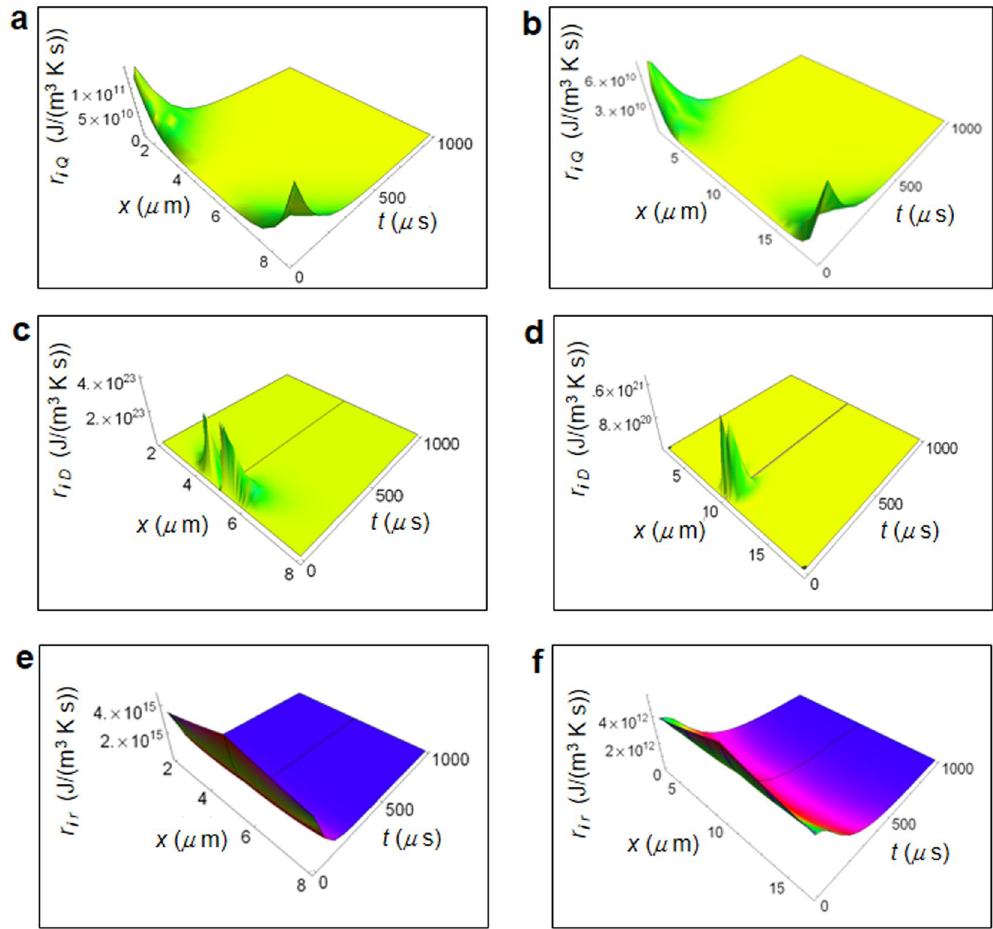
Figure 2. Calculated RIEDP during glucose catabolism for a breast cell. ( a ) RIEDP associated to heat flow for a normal cell. ( b) RIEDP associated to heat flow for a cancer cell. ( c) RIEDP related to matter diffusion for a normal cell. ( d) RIEDP related to matter diffusion for a cancer cell. ( e) RIEDP due to irreversible reactions for a normal cell. ( f ), RIEDP due to irreversible reactions for a cancer cell.